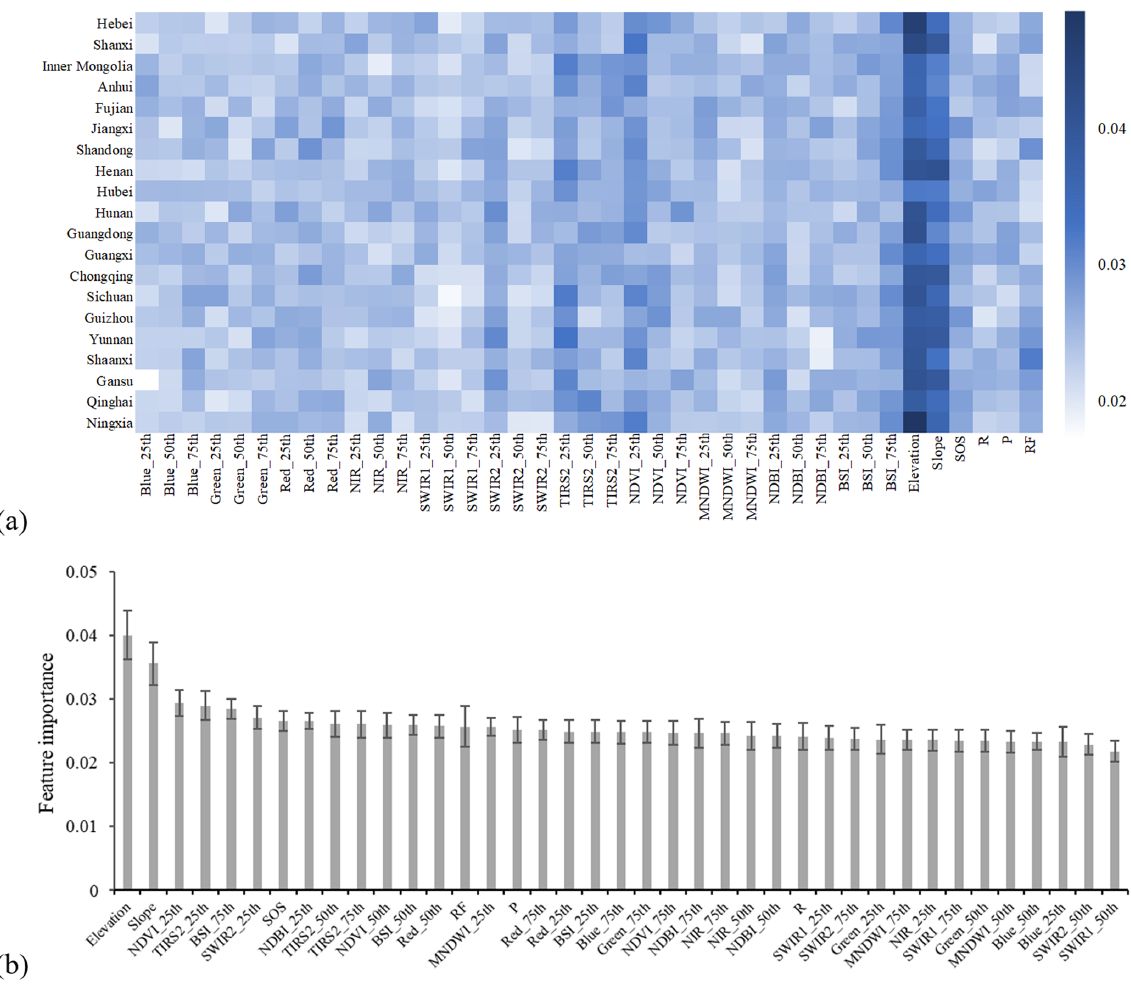
Figure 10. (a) Feature importance value for different provinces and (b) average feature importance of provinces. The error bars indicate the standard deviation. The variable names were explained in Table